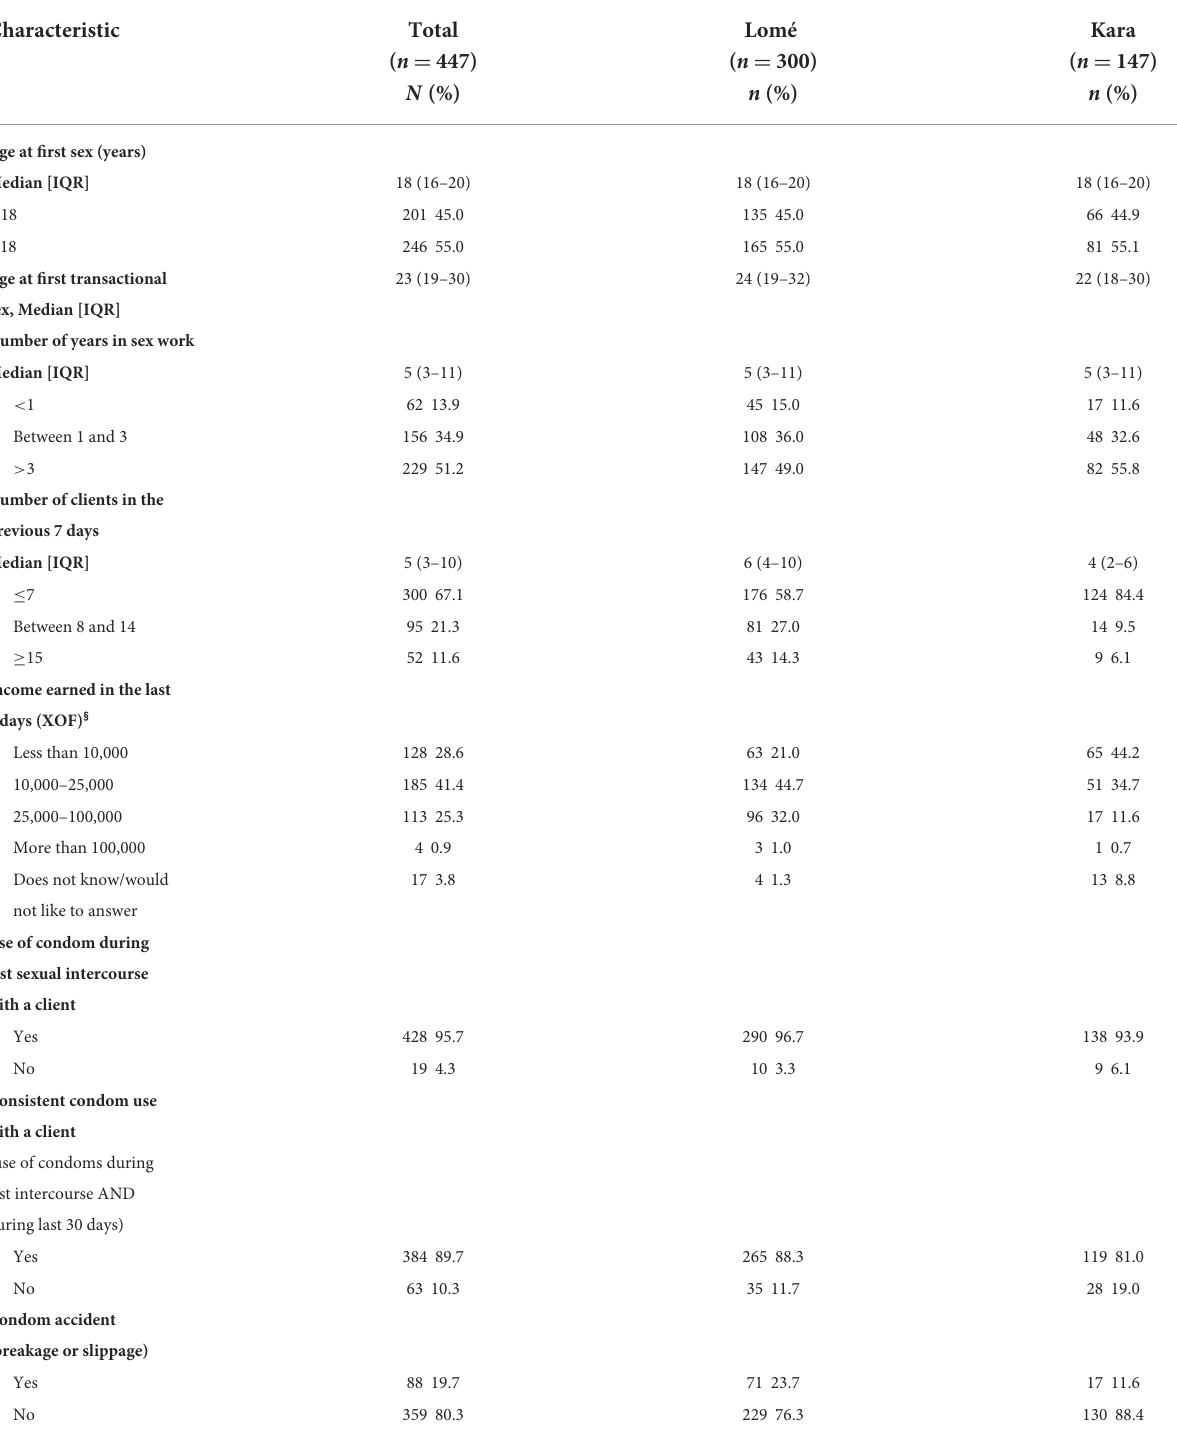
TABLE 1B Sexual history of female sex workers in Togo in 2021 ( N = 447).